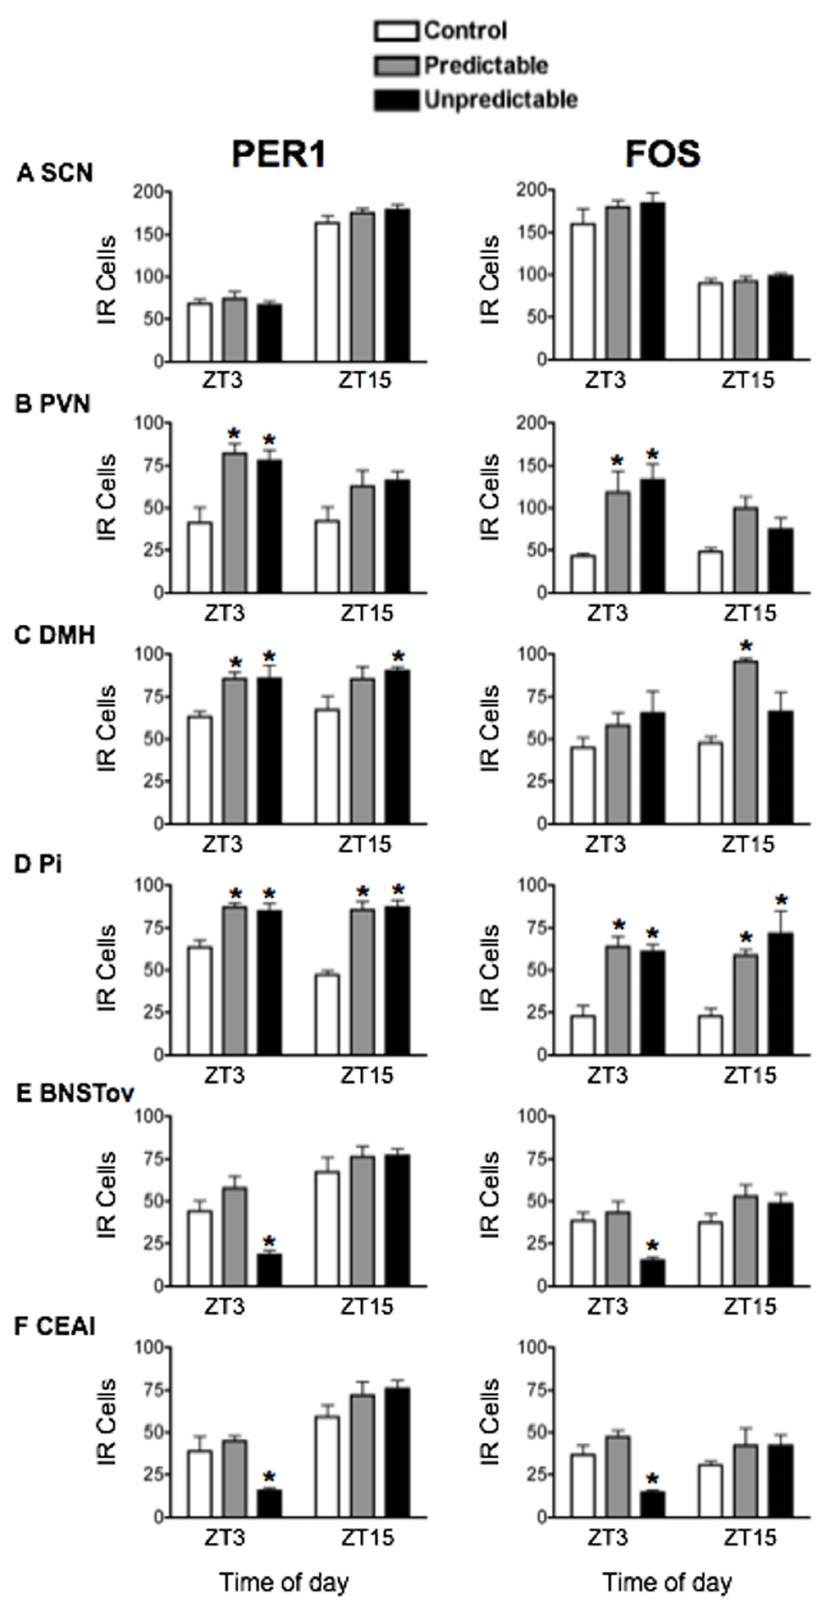
Figure 11. The effect of stress predictability on PER1 and FOS expression. Rats were exposed to repeated daily predictable vs. unpredictable 30 min restraint stress, administered at either ZT2 or ZT14, and killed 1 h later at ZT3 or ZT15. Means 6 SEM of immunoreactive (IR) cells are shown, n =4 per group; * significant difference from corresponding control group, p , 0.05. doi:10.1371/journal.pone.0111166.g011 PLOS ONE |